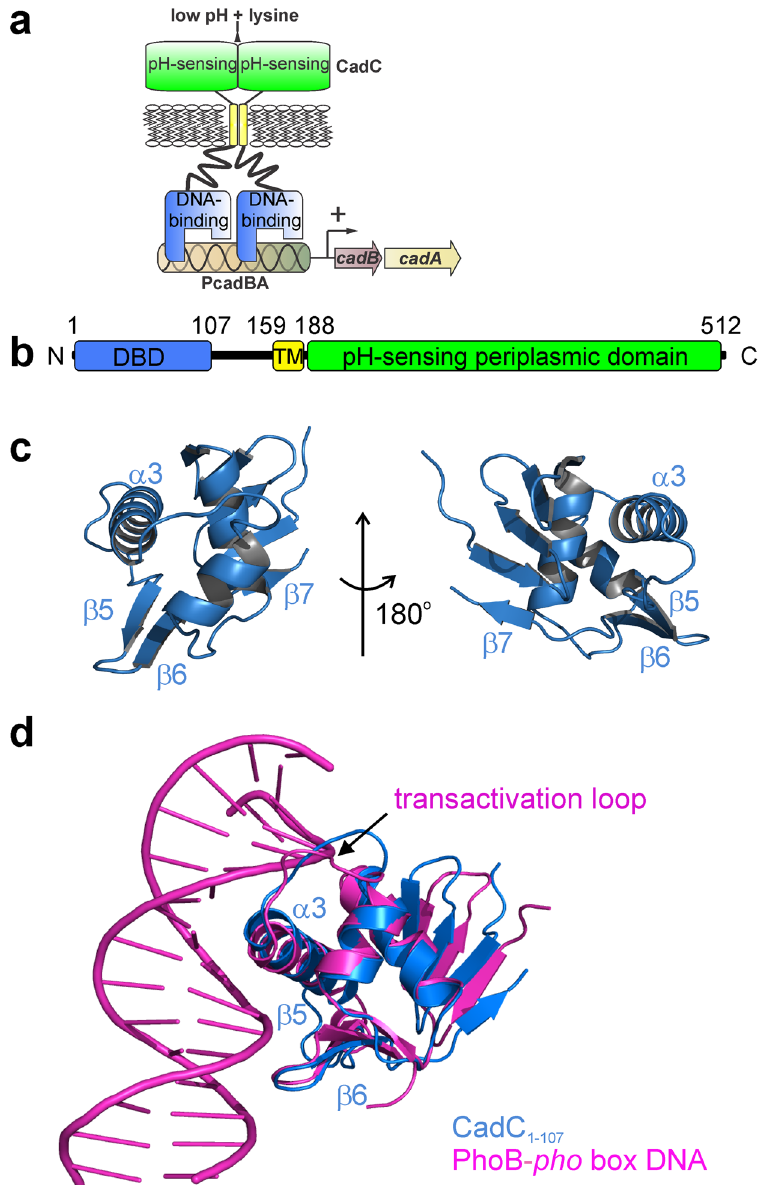
Figure 1. Crystal structure of the CadC DNA-binding domain (DBD). ( a ) Scheme showing the transcriptional activation of cadBA genes by CadC in dependence of low pH and increased lysine concentration. The mechanism requires dimerization and therefore two DBDs are shown to bind the cadBA promoter (PcadBA). ( b ) Scheme showing the domain organization of CadC from E. coli . The DNA-binding domain is shown in blue. Numbers indicate amino acid positions. TM, transmembrane domain. ( c ) Cartoon representation of the E . coli CadC 1-107 DBD from two views. Selected secondary structure elements are annotated. ( d ) Superposition of CadC 1-107 (blue) as in ( c ) with the bacterial transcriptional activator PhoB in complex with DNA (magenta) 16 . Note that only one PhoB monomer and only part of the DNA are shown for clarity. Secondary structure elements involved in DNA-binding by CadC are annotated. The PhoB transactivation loop necessary for binding to RNA polymerase is indicated. Pictures were created with PyMol (Delano